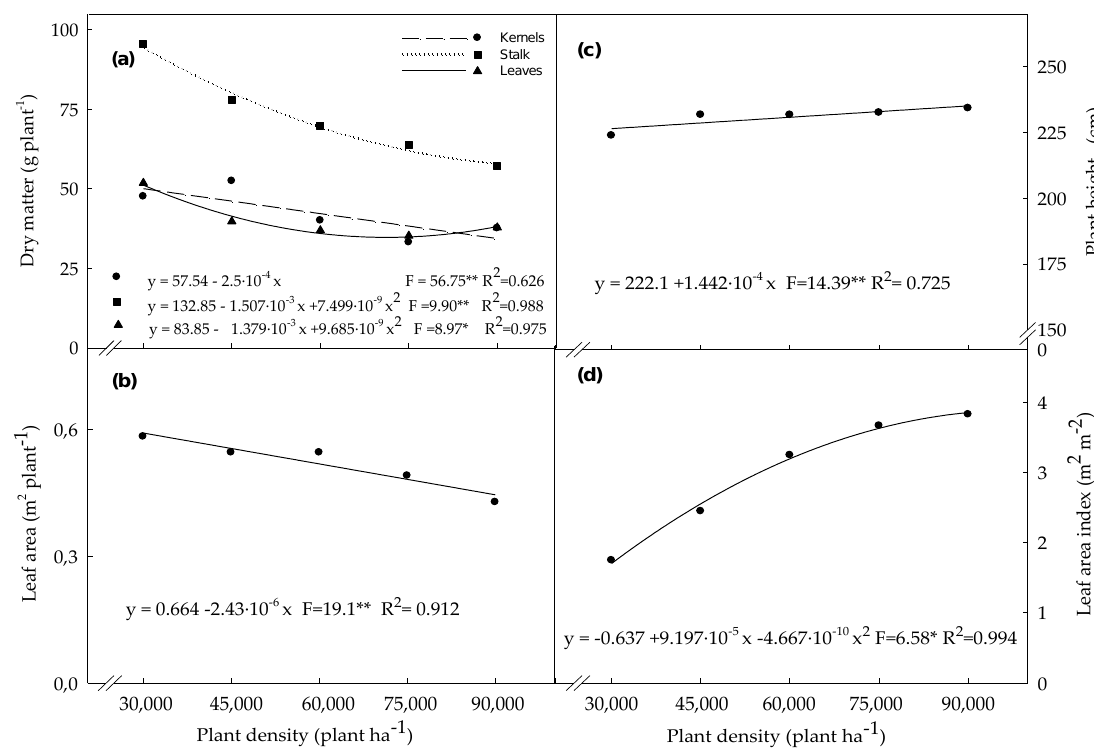
Figure 2. Kernel, leaf, and stalk dry weight per plant ( a ), plant leaf area ( b ), plant height ( c ), and leaf area index ( d ) of corn plants at the R4 stage, as a function of the plant density, ranging from 30,000 to 90,000 plants per hectare. Statistical data were obtained from four field replications. F = F test result of the regression analysis; (*) and (**) indicate that the F test revealed statistical significance at p ≤ 0.05 and p ≤ 0.01, respectively; R 2 = determination coefficient.